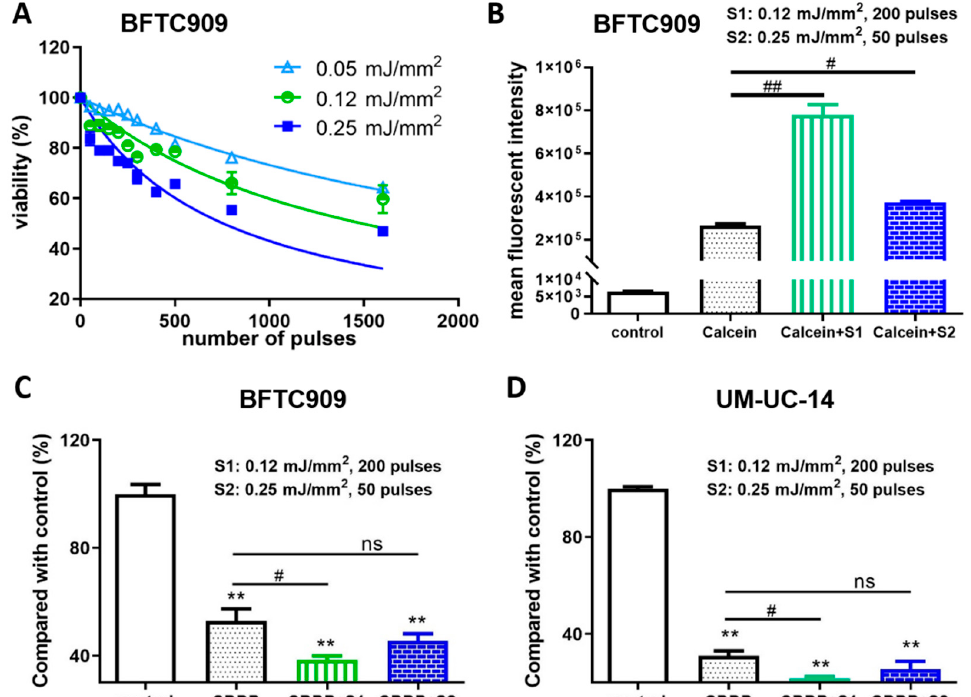
Figure 1. Shock wave treatment enhanced the antitumour effect of cisplatin (CDDP) in vitro. ( A ) Determination of optimal conditions of shock waves for human UTUC BFTC909 cell line. BFTC909 cells were treated with the indicated number of shock wave pulses at 0.05, 0.12, and 0.25 mJ/mm 2 . ( B ) BFTC909 cells were treated with 0.2 mM Calcein combined with 200 shock wave pulses at 0.12 mJ/mm 2 (S1) or 50 pulses at 0.25 mJ/mm 2 (S2) and Calcein permeability was assessed by flow cytometry. Data are denoted as mean ± SEM, n = 3, the p values were calculated with one-way ANOVA followed by Tukey’s multiple-comparison test, # p < 0.05 versus Calcein group, ## p < 0.01 versus Calcein group. BFTC909 ( C ) and UM-UC-14 ( D ) cells were treated with 3 μ M cisplatin combined with shock wave treatment as described. After 72-h treatment, cell proliferation was assessed using the MTT assay. Data are denoted as mean ± SEM, n = 6, the p values were calculated with one-way ANOVA followed by Tukey’s multiple-comparison test, ** p < 0.01 versus control group, # p < 0.05 versus CDDP group, ns indicates no significance.